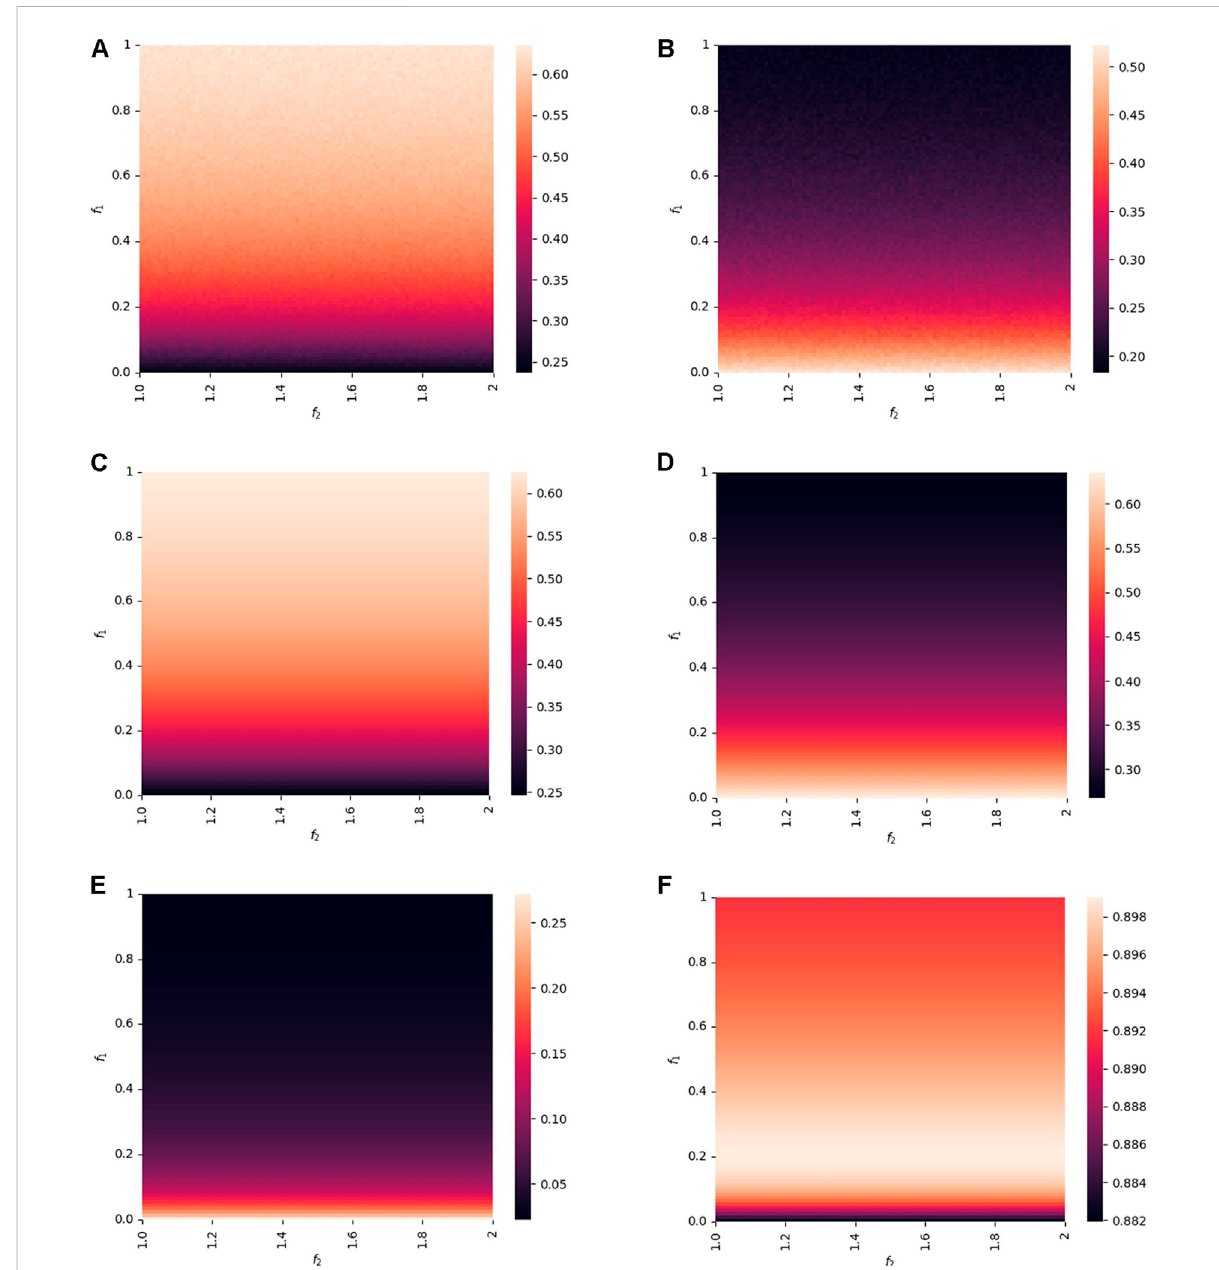
FIGURE 7 Proportionsof ρ A 1 I and ρ A 1 S byMMCA and MCsimulationas functions of f 1 and f 2 (the positive and negativeawarenessperception, respectively.) The proportions get larger when the color varies from dark to light. Each heat map consists of 100 × 100 lattice points. (A,C) ρ A 1 I obtained by MC simulation and MMCA, respectively. (B,D) ρ A 1 S obtained by MC simulation and MMCA, respectively. (E,F) ρ A 1 and β c obtained by MMCA. Other parameters are the same as the default